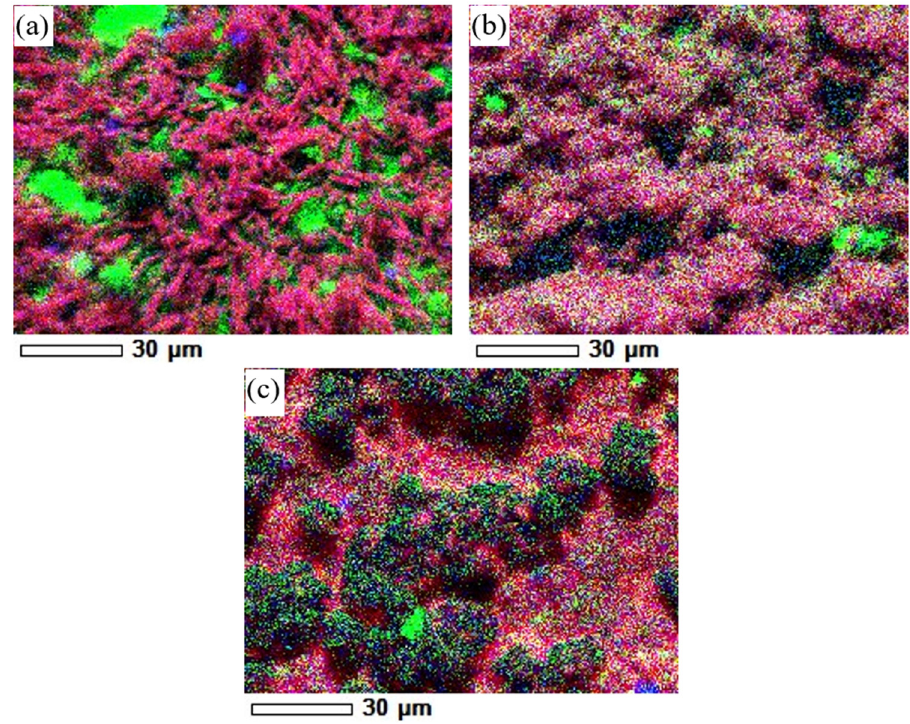
Figure 5: SEM mappings of Bi/AC composites prepared with ( a ) 8 mmol, ( b ) 24 mmol, and ( c ) 32 mmol